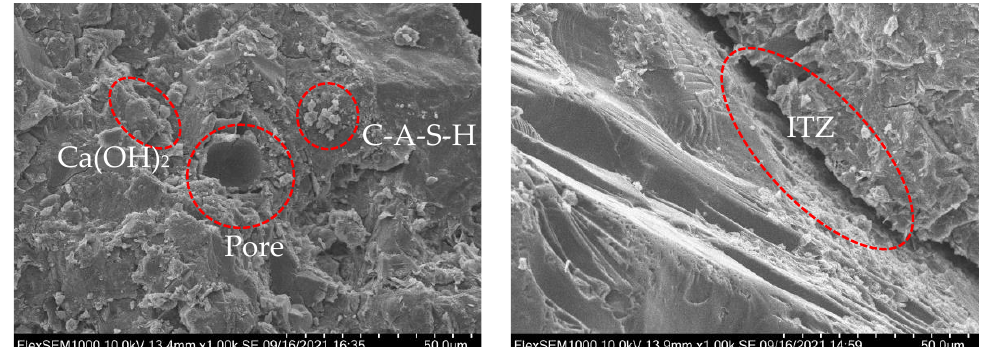
Figure 8. SEM image.